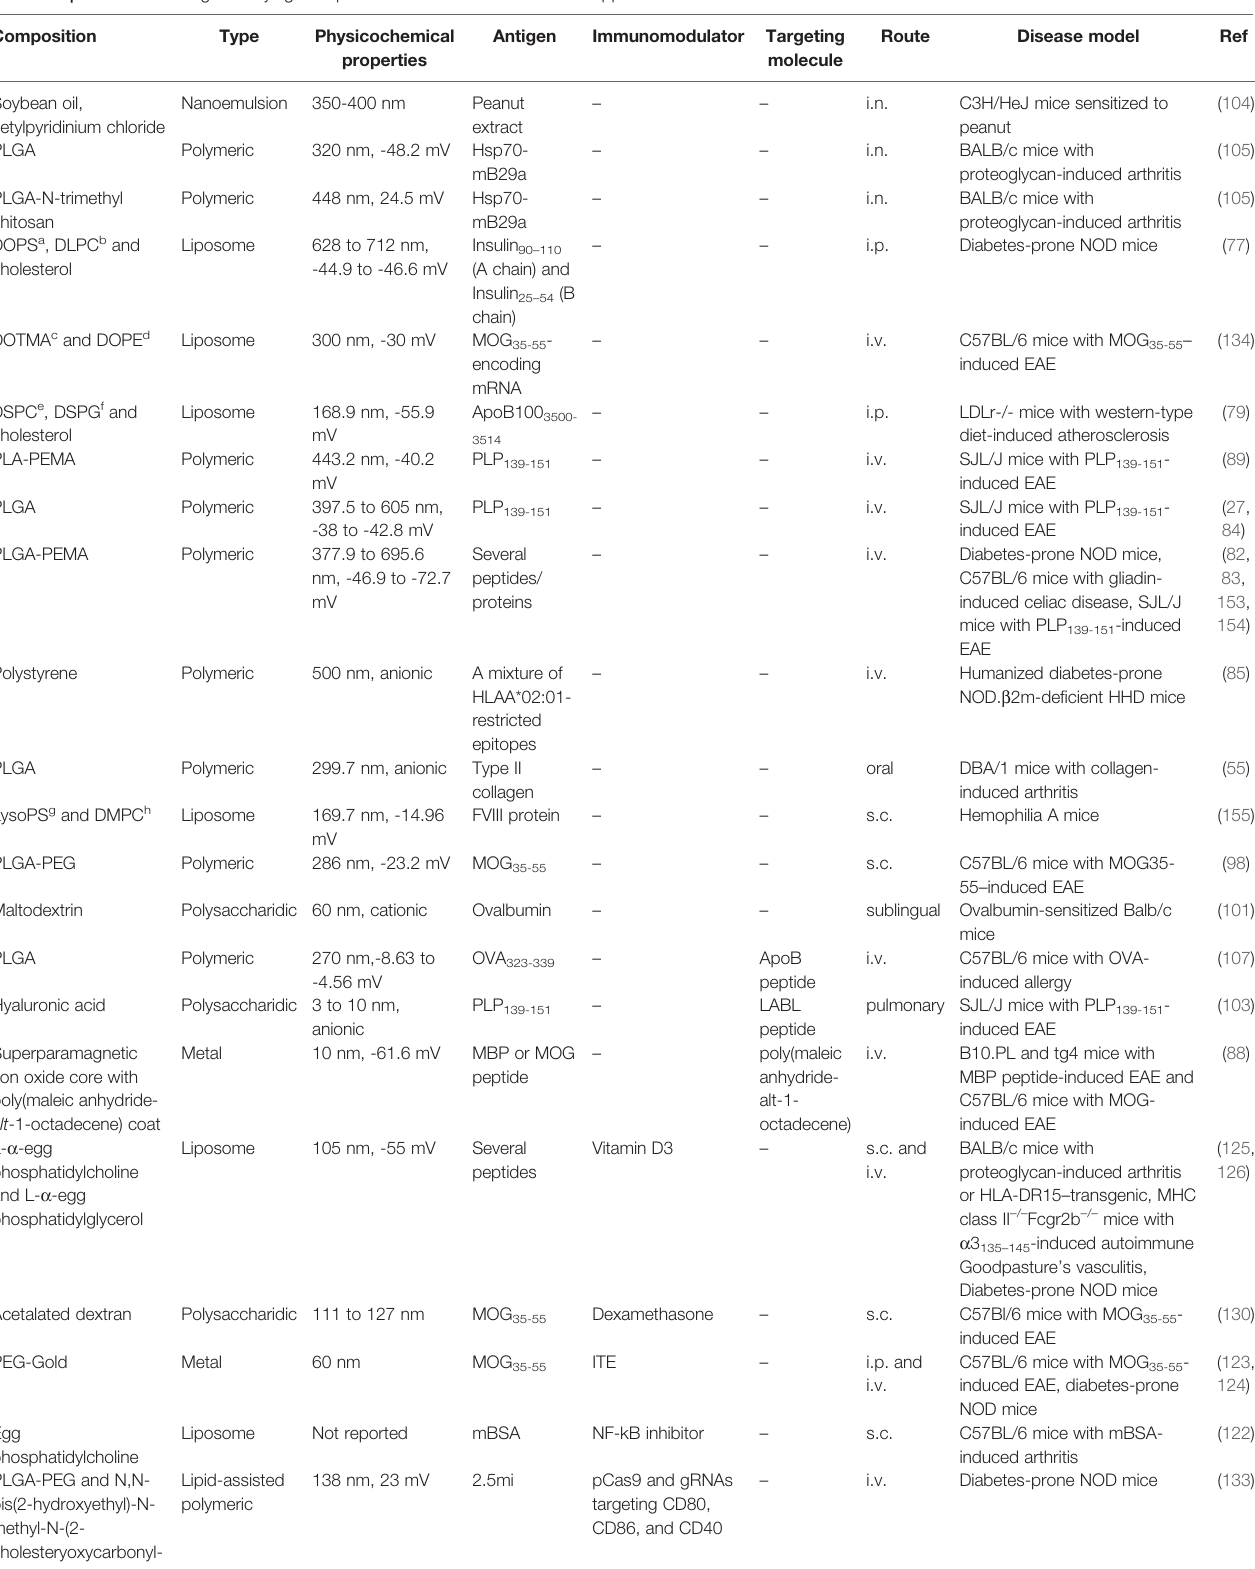
TABLE 1 | Overview of antigen-carrying nanoparticles that resulted in immune suppression in autoimmune disease